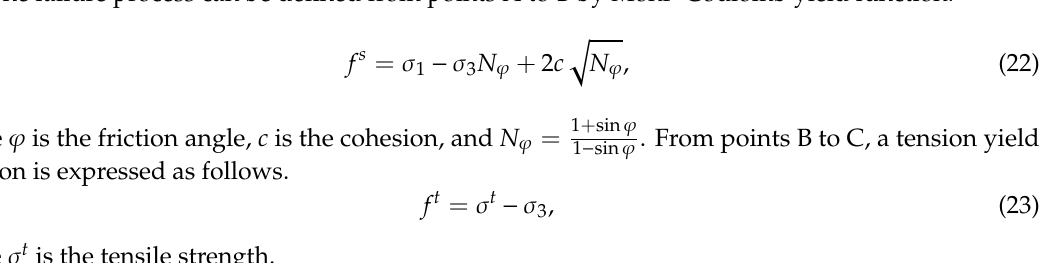
Figure 7. The constitutive behavior of the contact [61].